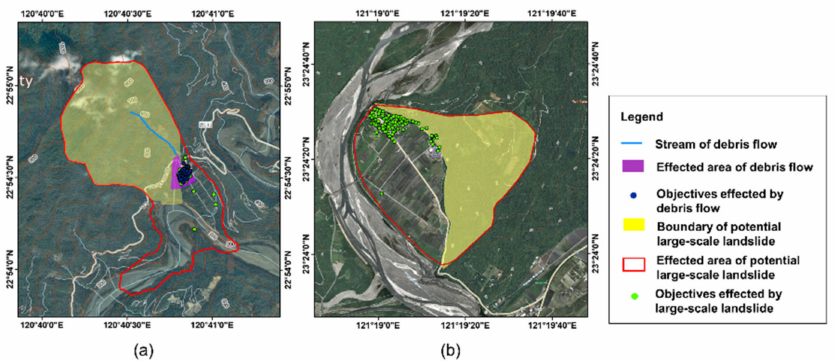
Figure 15. Classification of warning systems for large-scale landslide. ( a ) Type 1: those that overlap with existing debris flow protected targets; ( b ) type 2: those that have no overlap with the existing debris flow protected targets.